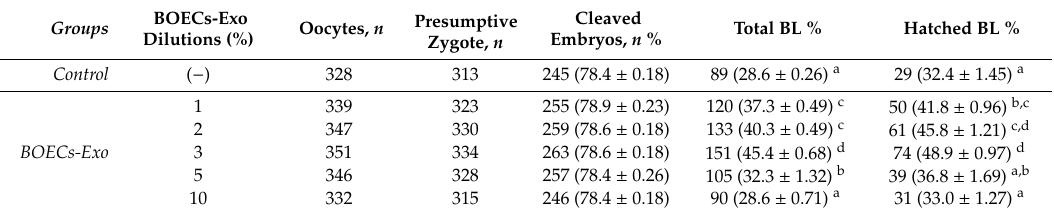
Table 2. E ff ect of di ff erent dilutions of BOECs Exosomes and BL yield during in